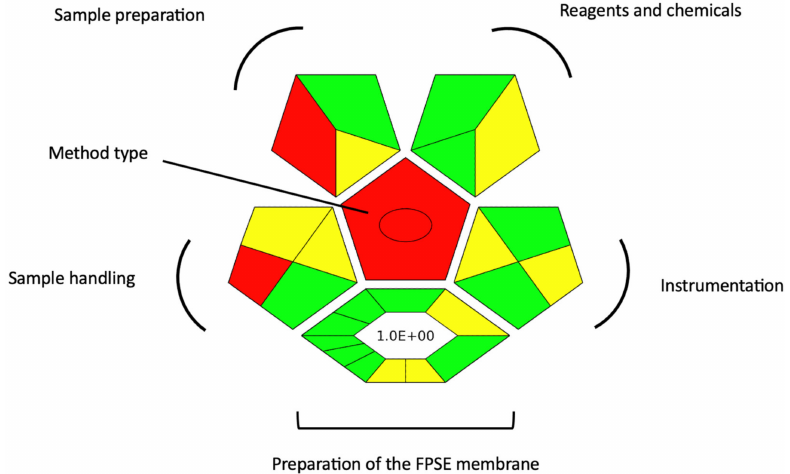
Figure 5. ComplexGAPI pictogram for the FPSE-HPLC-UV method. Green colour indicates compli- ance with the requirements.